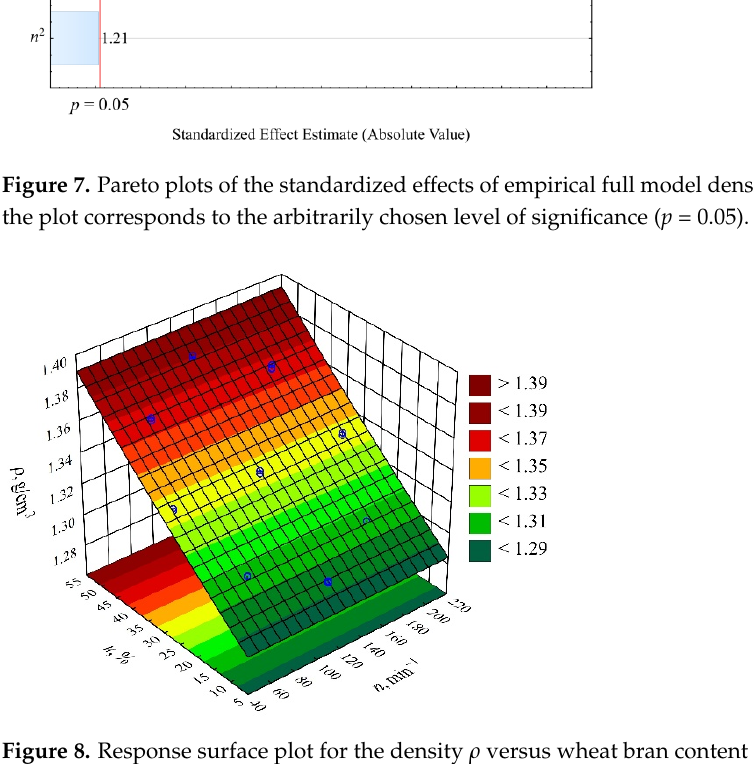
Figure 8. Response surface plot for the density ρ versus wheat bran content u and screw speed n.